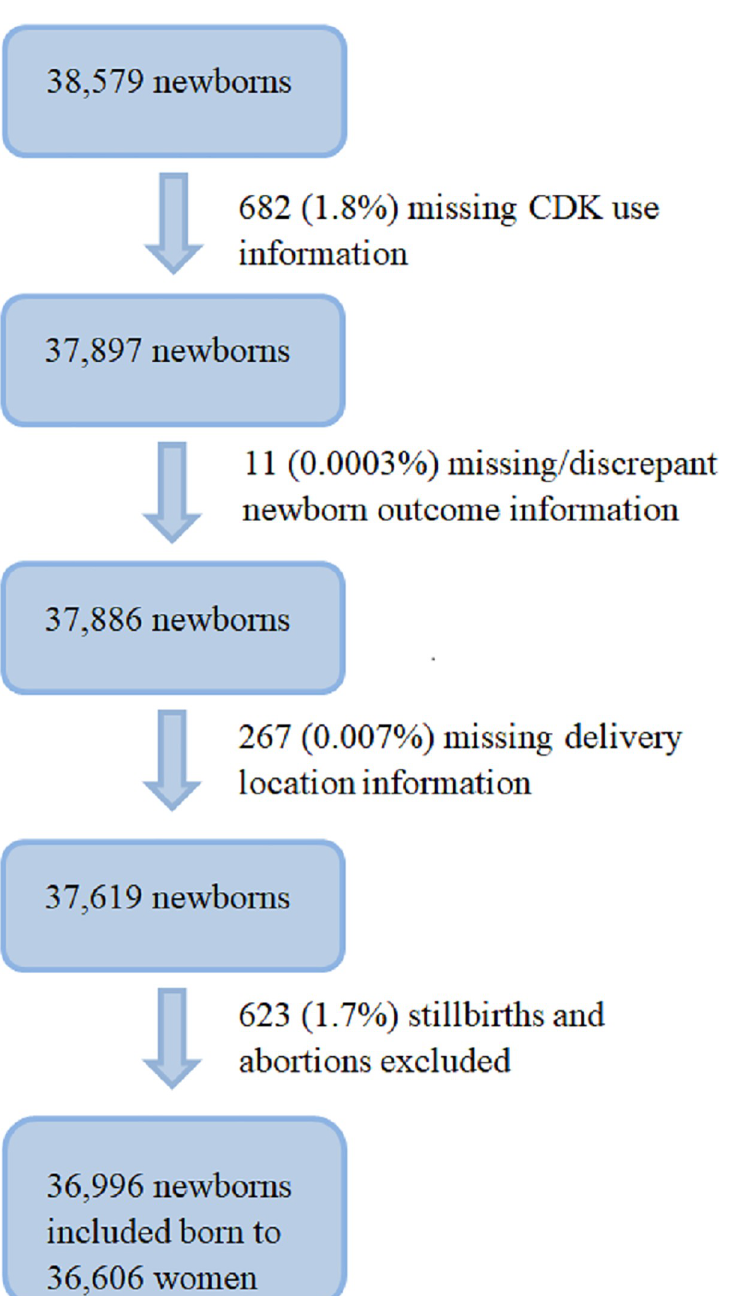
Fig 1. Participant flow chart. CDK, clean delivery